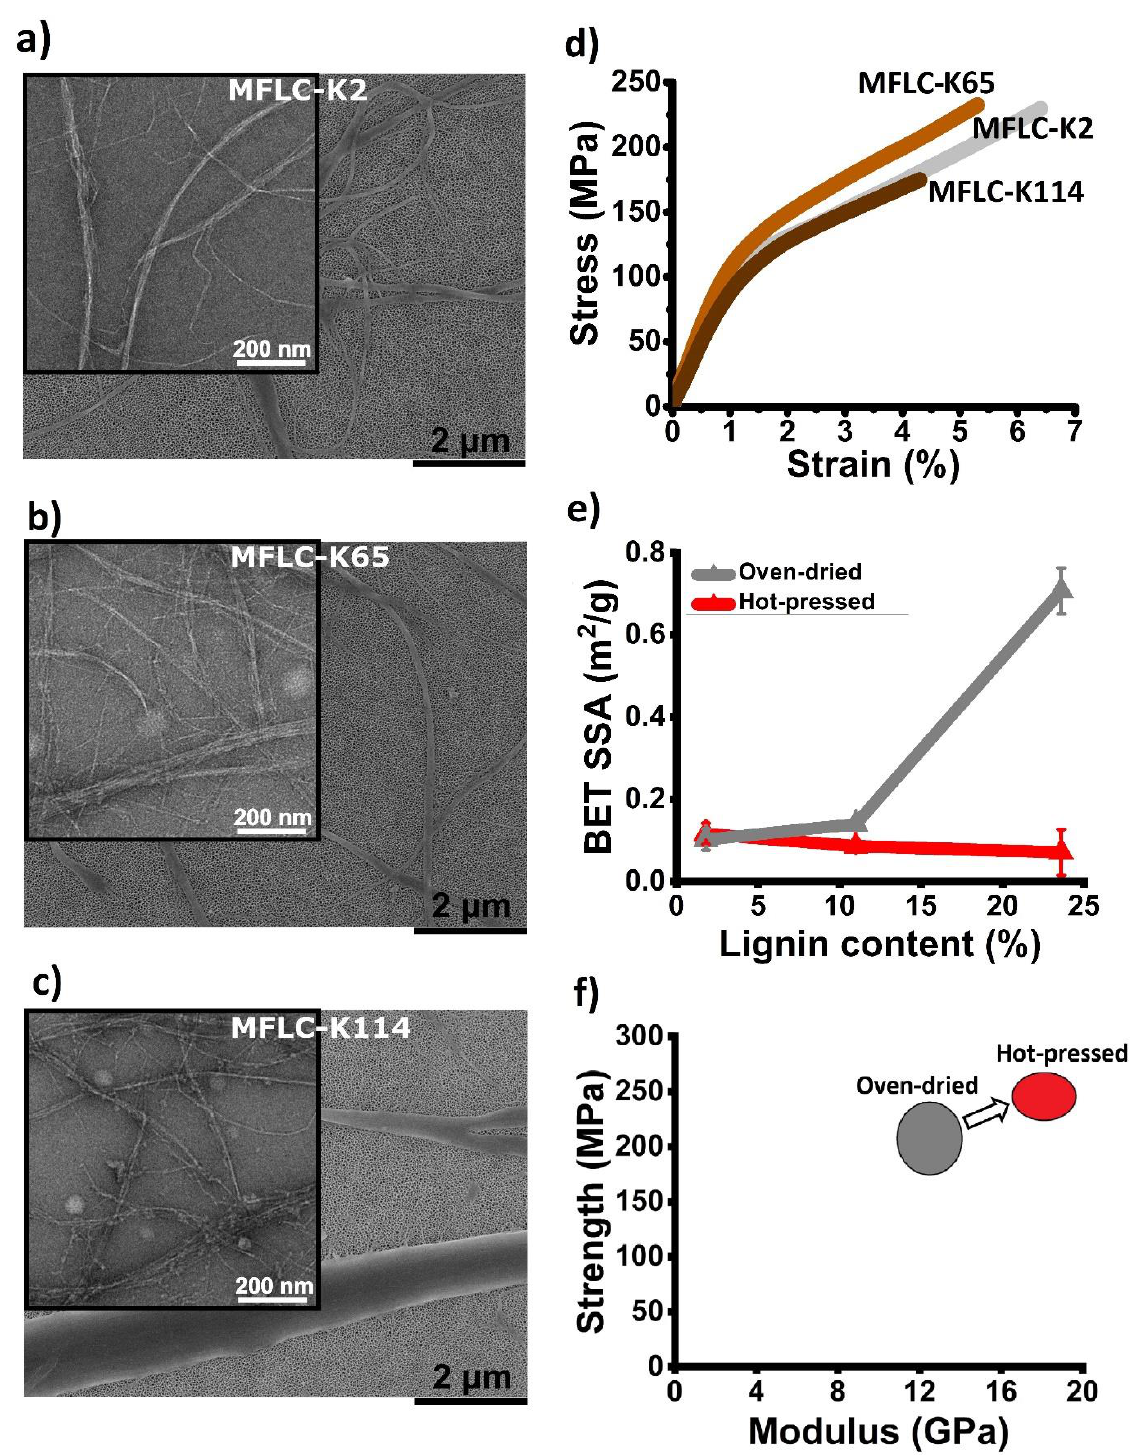
Figure 4. SEM and TEM images of ( a ) MFLC-K2 (2% lignin, 2.5 nm-0.8 µm fibril diameter Ø , 42 wt% nano-sized) [14] , ( b ) MFLC-K65 (11% lignin, 2.5 nm – 0.8 µm Ø , 53 wt% nano-sized) [14] , and ( c ) MFLC-K114 (24% lignin, 2.5 nm – 2 µm Ø , 24